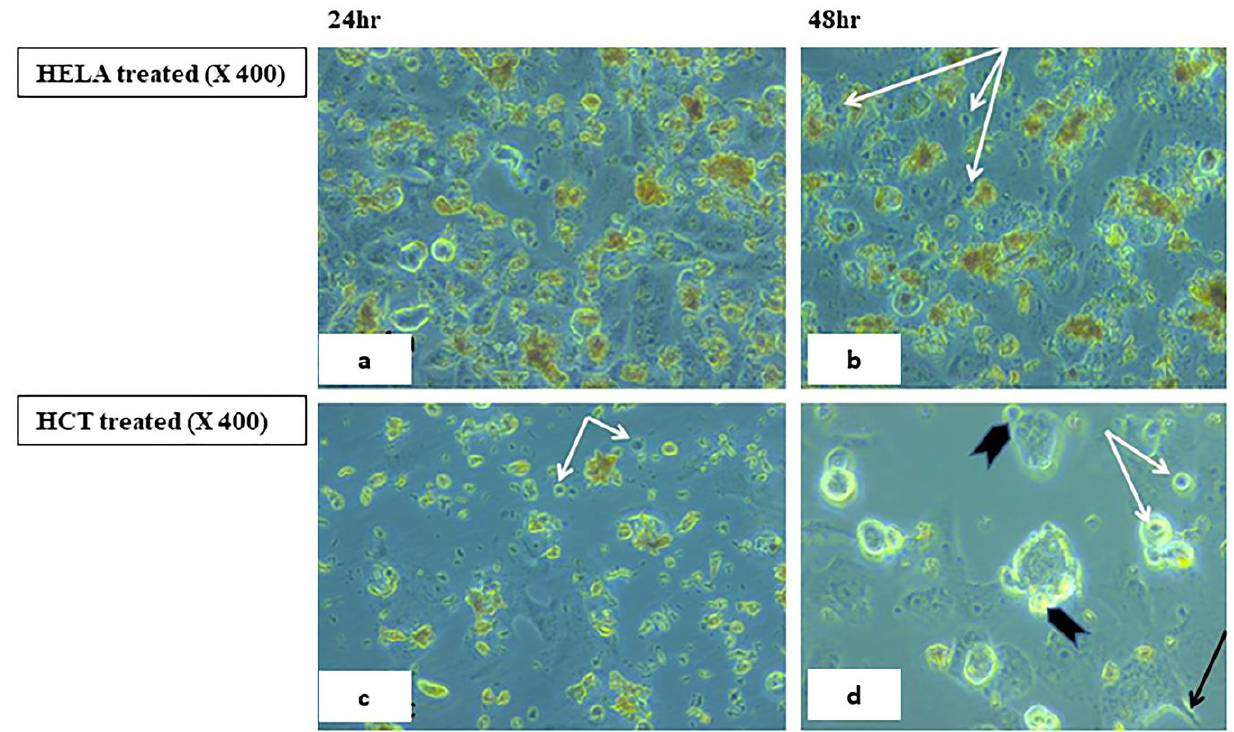
Figure 11. Human HELA and HCT treated cell lines 24,48 h after incubation with 9H . Panels ( a , c ) reveal few adherent spindle shaped cells (20% confluent), some polygonal cells and floating unhealthy disrupted cells. Panel ( b , d , shows few adherent cells with features of apoptosis such as cell shrinkage and pyknotic bodies of condensed chromatin (white arrows), membrane blebbing (arrow heads), echinoid spike (black arrow), and some rounded floating disrupted cells. Phase contrast 400 ×